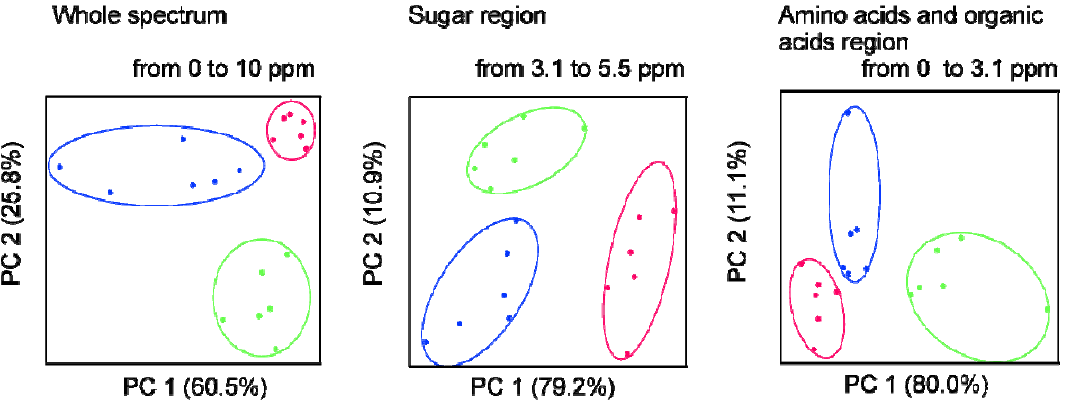
Figure 1. Principal component analysis (PCA) of 1 H NMR spectra of tomato fruit. 1 H NMR spectra of samples of pericarp extract of green (green line), red ripened on-the- vine (red line) and red ripened off-the-vine (blue line) Micro-Tom fruits were analyzed considering the whole spectra (each spectrum was normalized to a maximum intensity of 1, the water region was removed) and distinct spectral